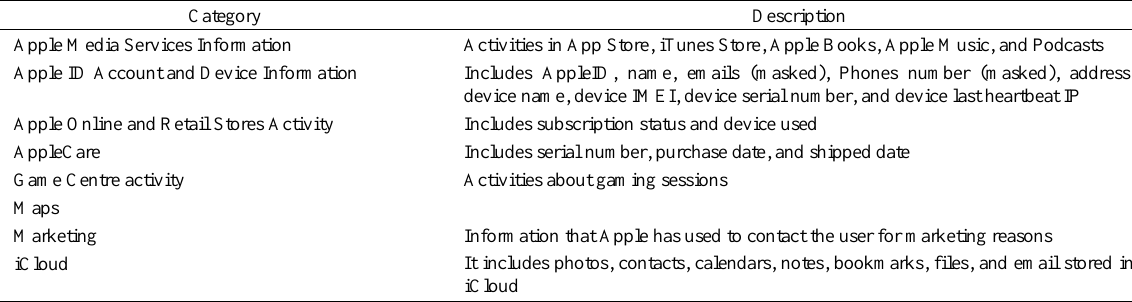
Table 4. Few data retrievable on apple device